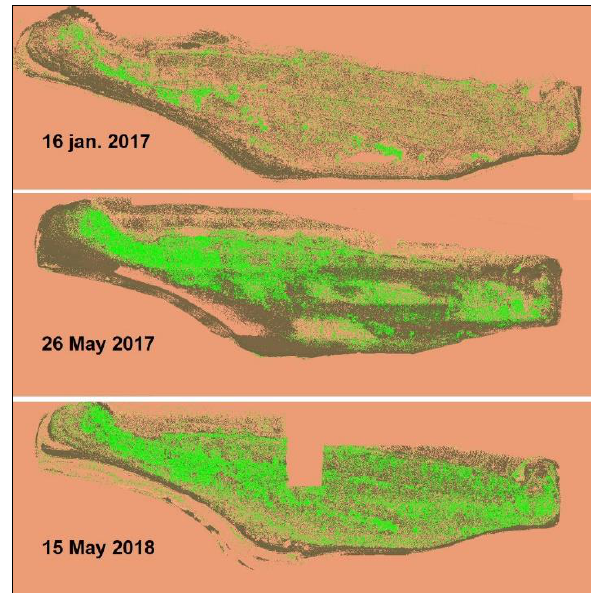
Figure 7. Representation of vegetation image of Jinu-do displayed in QGIS on digital orthophoto